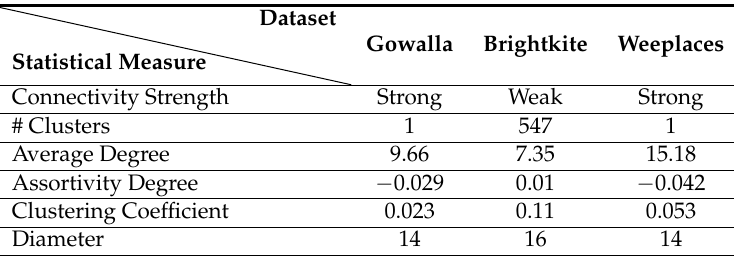
Table 2. Statistical measures for different